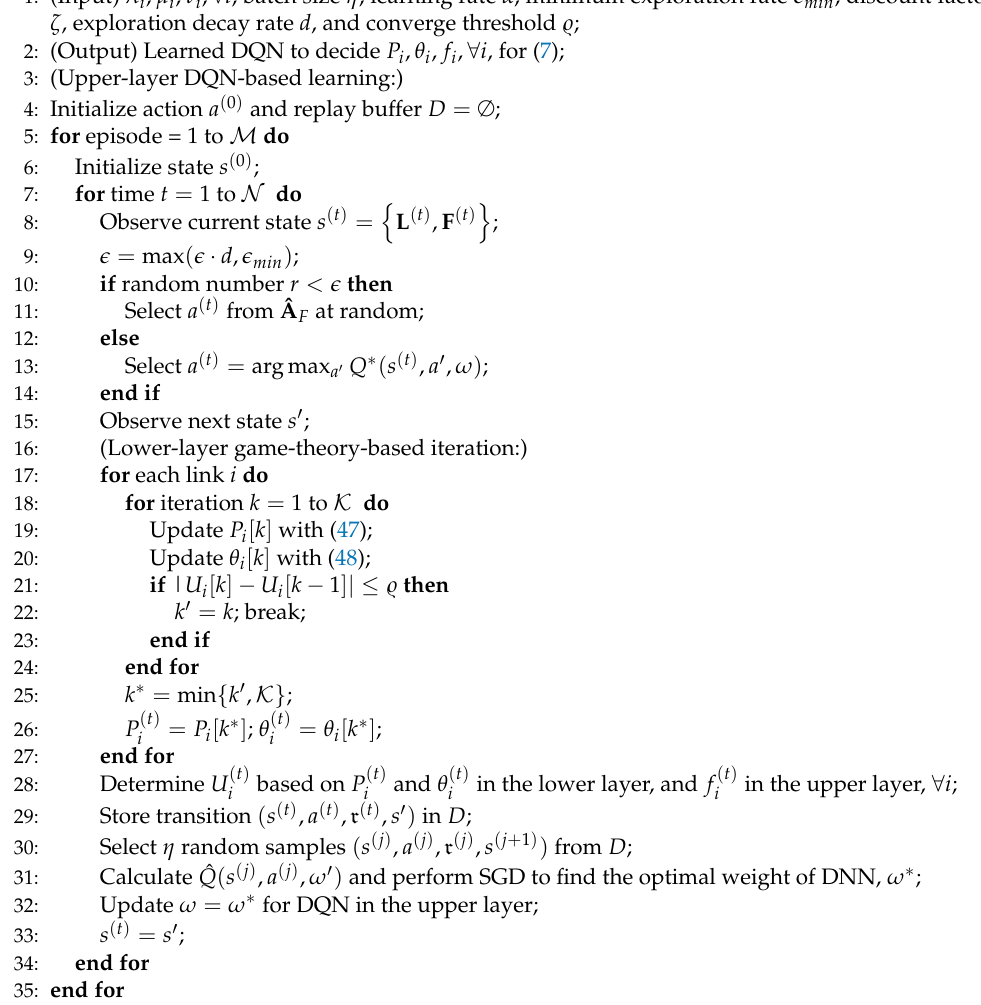
Algorithm 3 The two-layer hybrid MRA training